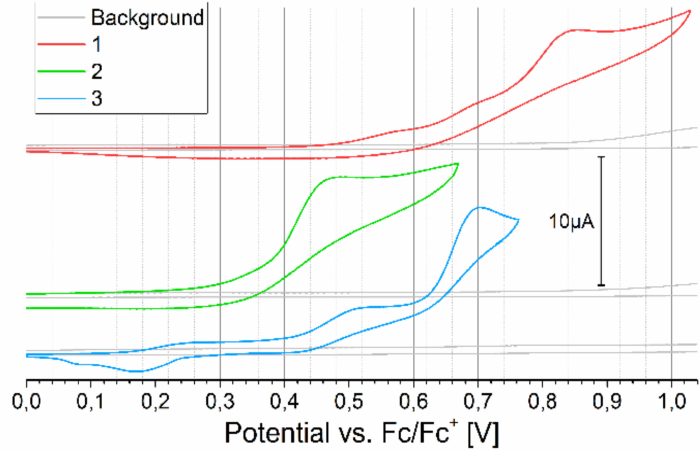
Figure 4. The cyclic voltammetry (CV) of oxidation of monomers versus ferrocene redox couple, concentration 2 mmol / dm 3 in DCM, 100 mV /